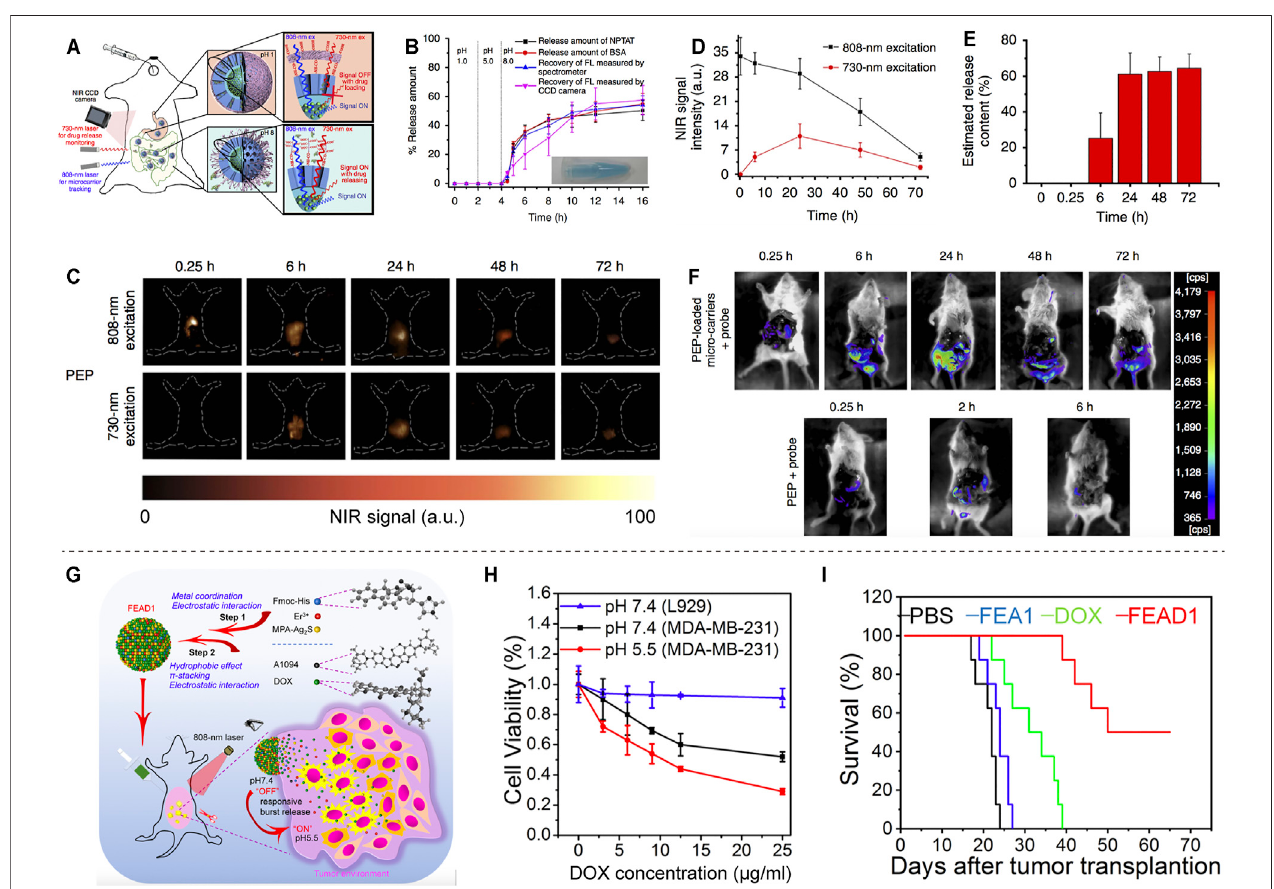
FIGURE 5 | NIR-II based drug delivery. (A) Schematic illustration of the absorption competition-induced emission bioimaging system. (B) The release pro fi les of microcarriers in simulated gastrointestinal tract fl uids. (C) Fluorescence imaging ofmice after gavage with PEP-NPTAT-loaded microcarriers under excitation. (D) Signal intensity of (C) . (E) In vivo release percentage of PEP-NPTAT from microcarriers. (F) Fluorescence imaging of mice after gavage with PEP-NPTAT-loaded microcarriers and a peptide probe, and PEP molecules and a peptide probe (reproduced from (Wang et al., 2017) with permission from Springer Nature). (G) Schematic illustration ofthesynthesisofFEAD1and capability fortumor theranostics. (H) CellviabilityofL929 andMDA-MB-231 cellsunderdifferenttreatments. (I) Survivalcurves of mice following different treatments (reproduced from (Ling et al., 2020) with permission from John Wiley and Sons).